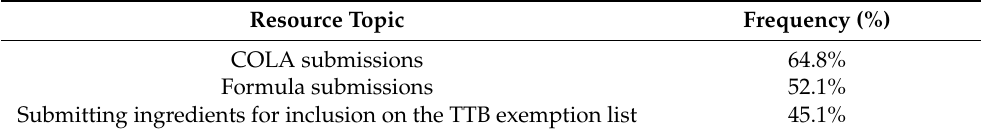
Table 17. Frequency of Participants that Indicated Interest in Additional COLA and Formula Re-